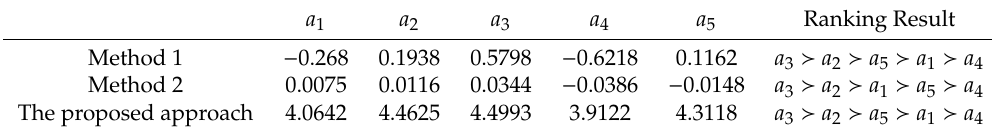
Table 13. Ranking results of hotels based on different methods.